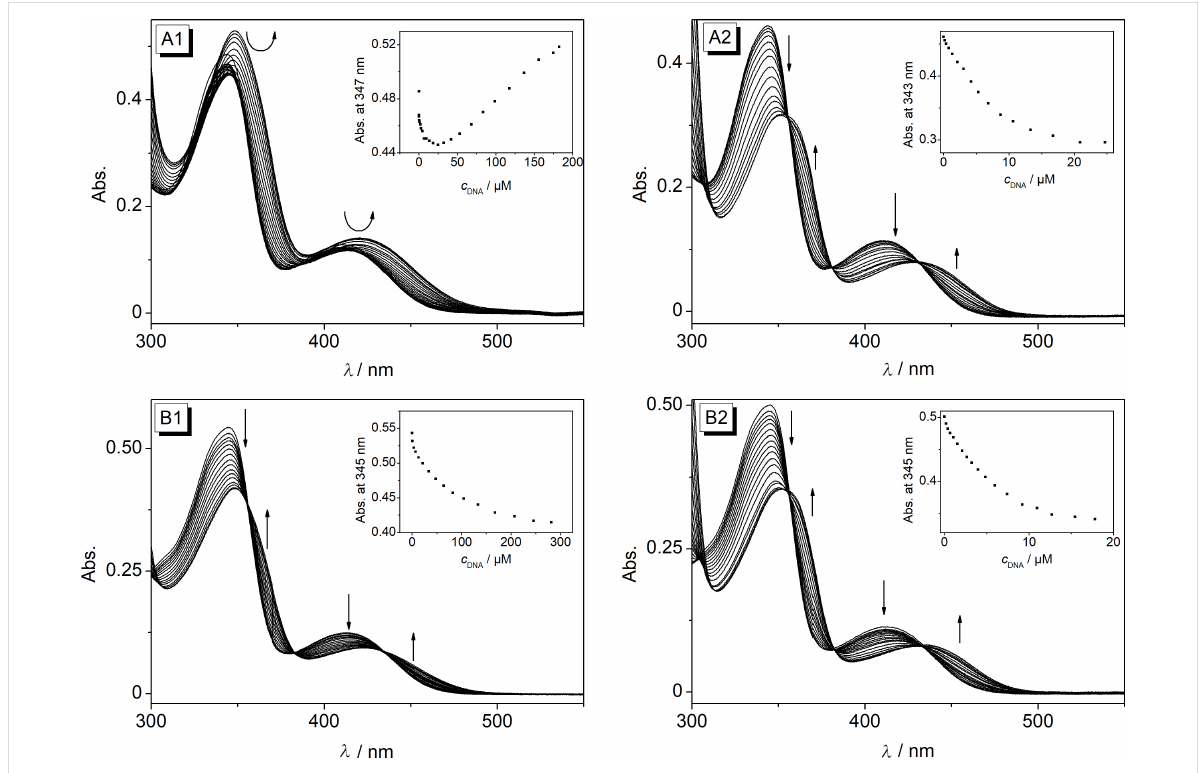
Figure 3: Photometric titration of 5a (A) and 5d (B) ( c Ligand = 20 μ M) with ct DNA (1) in BPE buffer ( c Na+ = 16 mM, pH 7.0, with 5% v/v DMSO) and with 22AG (2) in K-phosphate buffer ( c K+ = 110 mM, pH 7.0, with 5% v/v DMSO). The arrows indicate the changes of the absorption bands upon addi- tion of DNA. Inset: Plot of the ligand absorption versus c DNA (in base pairs).